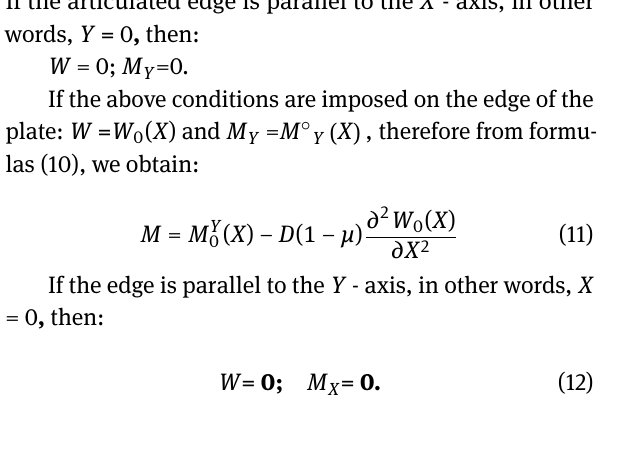
Figure 2: Square mesh for